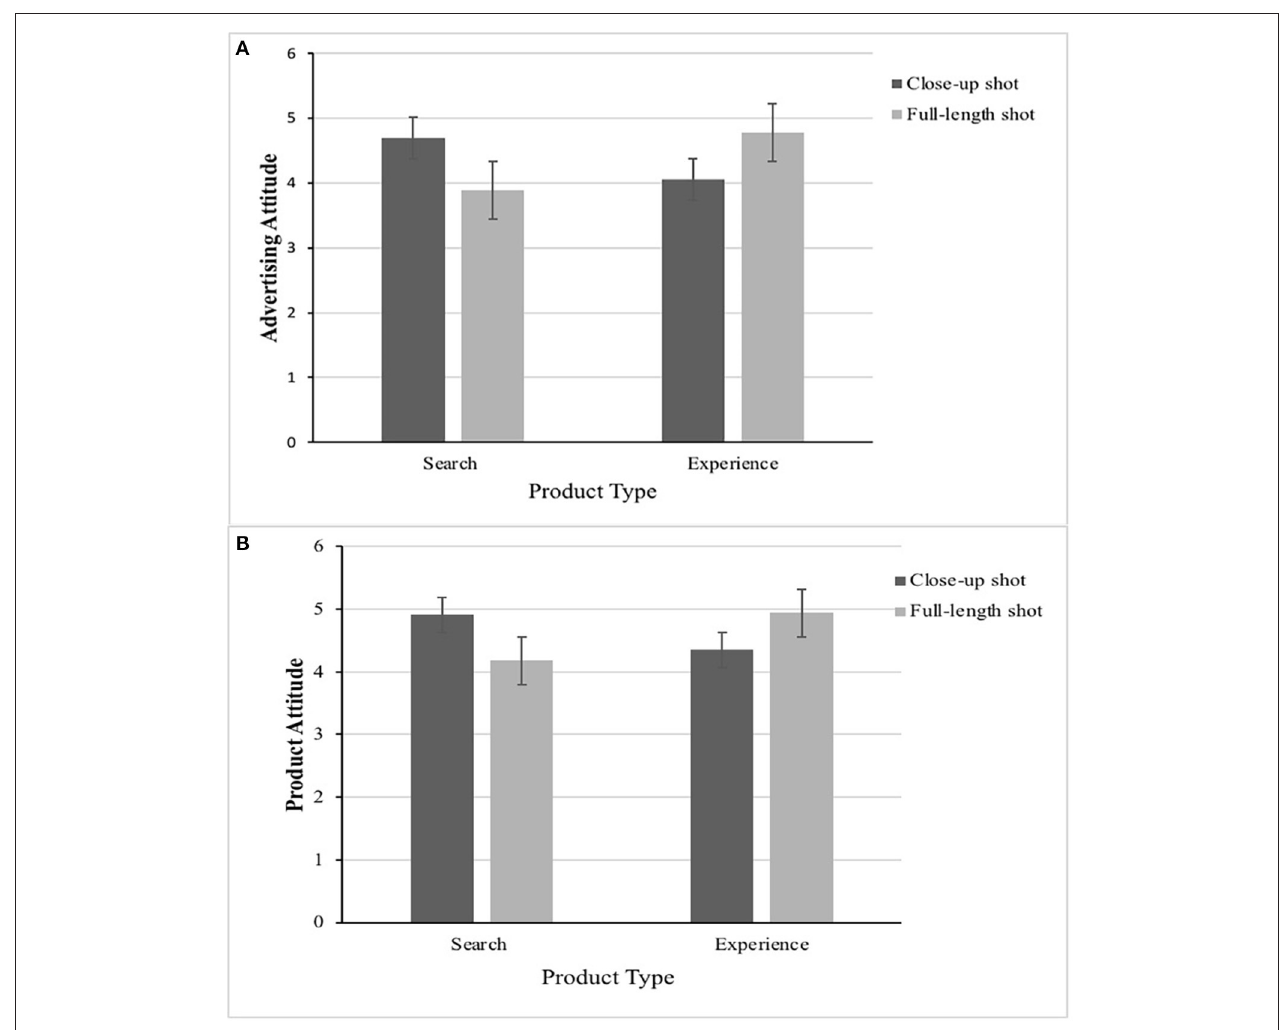
FIGURE 3 | The congruence effect between image proximity (close-up vs. full-length) and product type (search vs. experience) on advertising attitude (A) and product attitude (B) in Experiment 1.